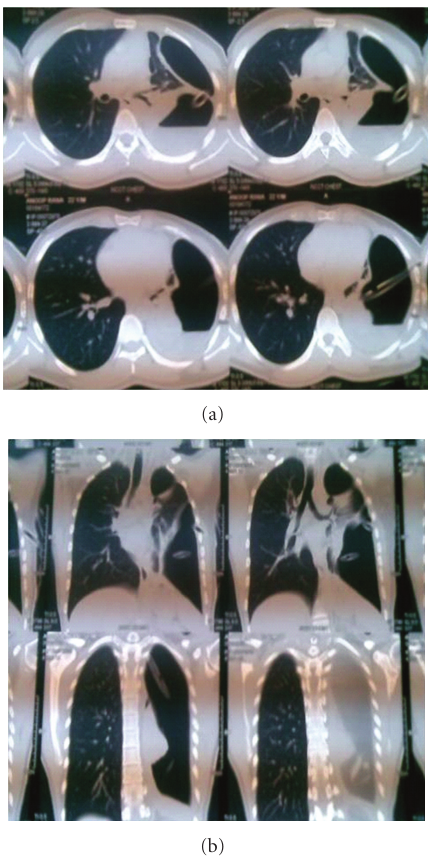
Figure 2: (a) (transverse sections) and (b) (coronal sections) contrast-enhanced computerised tomogram chest showing massive left pneumothorax with near complete collapse left lung and sig- nificant pleural thickening with adhesion to chest wall. Intercostal drain with residual pyothorax is also